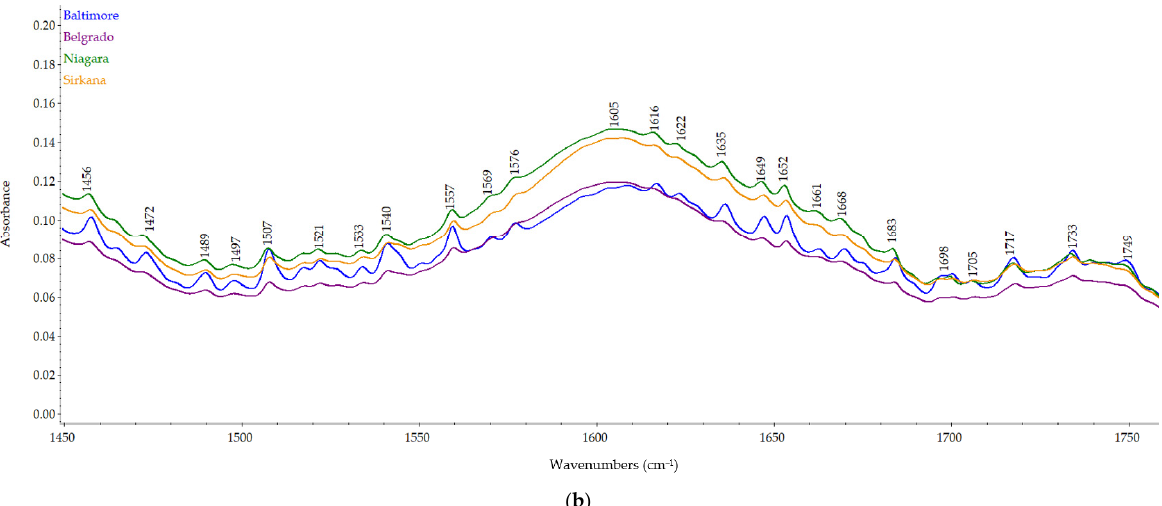
Figure 2. FT-IR spectra of carrot pomace powders: ( a ) in the range 650–4000 cm − 1 , and ( b ) in the range 1450–1750 cm − 1.